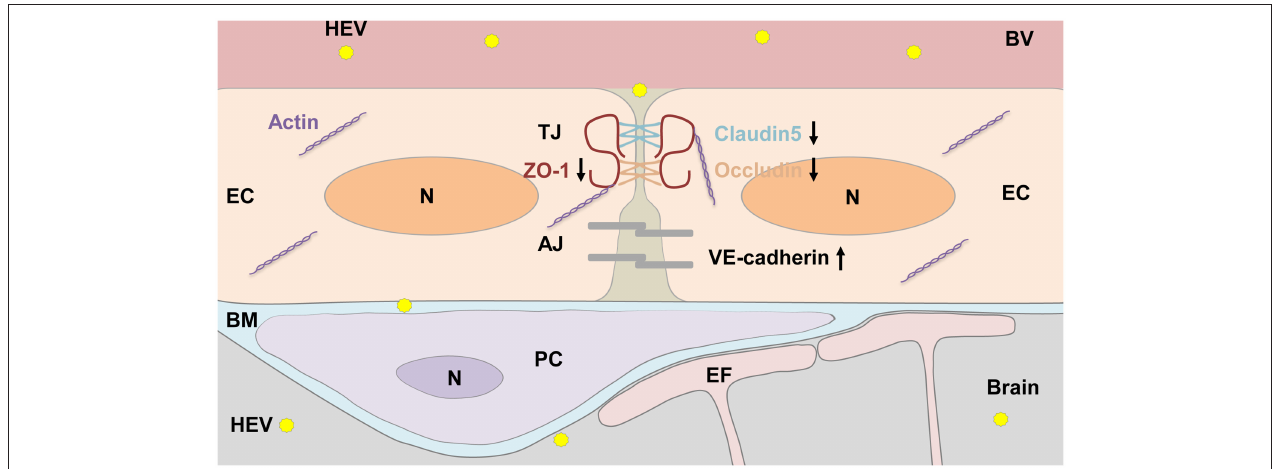
FIGURE 7 | HEV entry to the brain. Components of the BBB including tight junction (TJ) and adhesion junction (AJ) between endothelial cells (EC), pericytes (PC), astrocytes endfoot (EF), as well as basement membrane (BM) surrounded ECs and PCs were shown in the graph. HEV infection decreased expression levels of TJ proteins, including ZO-1, Occludin, and Claudin5, increased AJ protein VE-cadherin expression, leading disorder of junctional complexes between capillary ECs, further facilitating HEV invasion into the brain tissue. In responding, basement membrane of PCs and ECs became thickened to protect brain tissue from HEV infection. N, Nucleus; BV, blood